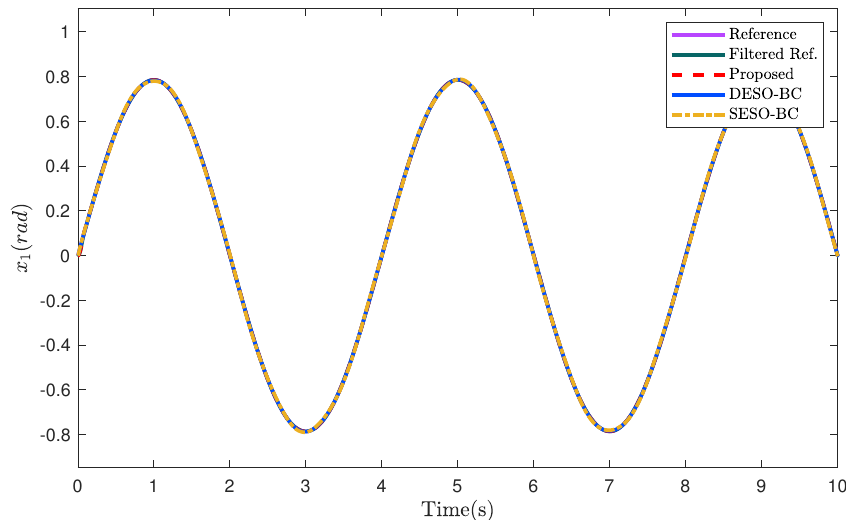
Figure 11. Tracking performances of all controllers in case of sinusoidal reference trajectory.